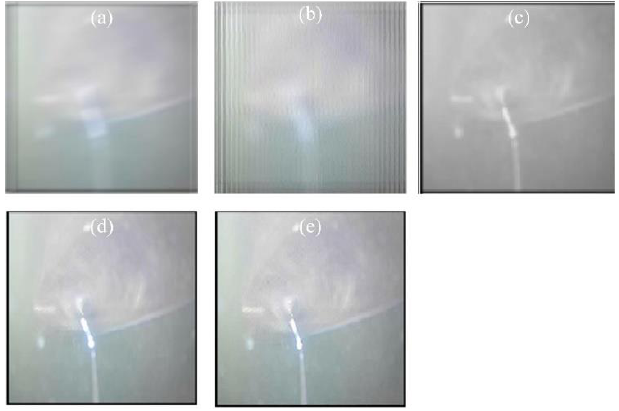
Figure 7. Sample image, restoration and reconstruction results: ( a ) sample image; ( b ) result of M − SB; ( c ) result of M − TV; ( d )result of PIV − RR; ( e ) result of the proposed method in this paper. Table 6. Comparison of evaluation results.